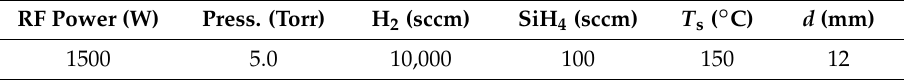
Table 1. a-Si:H deposition conditions, where d is the gap distance between the cathode and substrate. RF Power